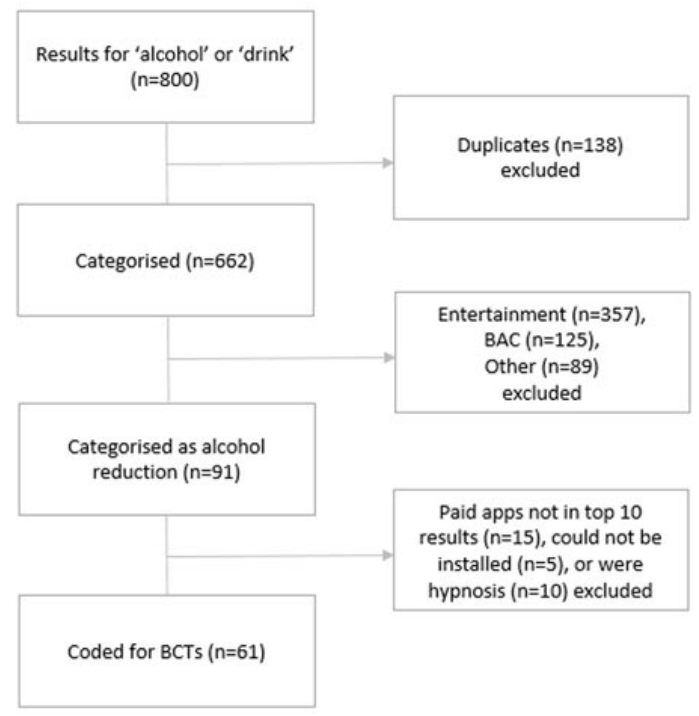
Figure 1. Flow diagram of apps selected for